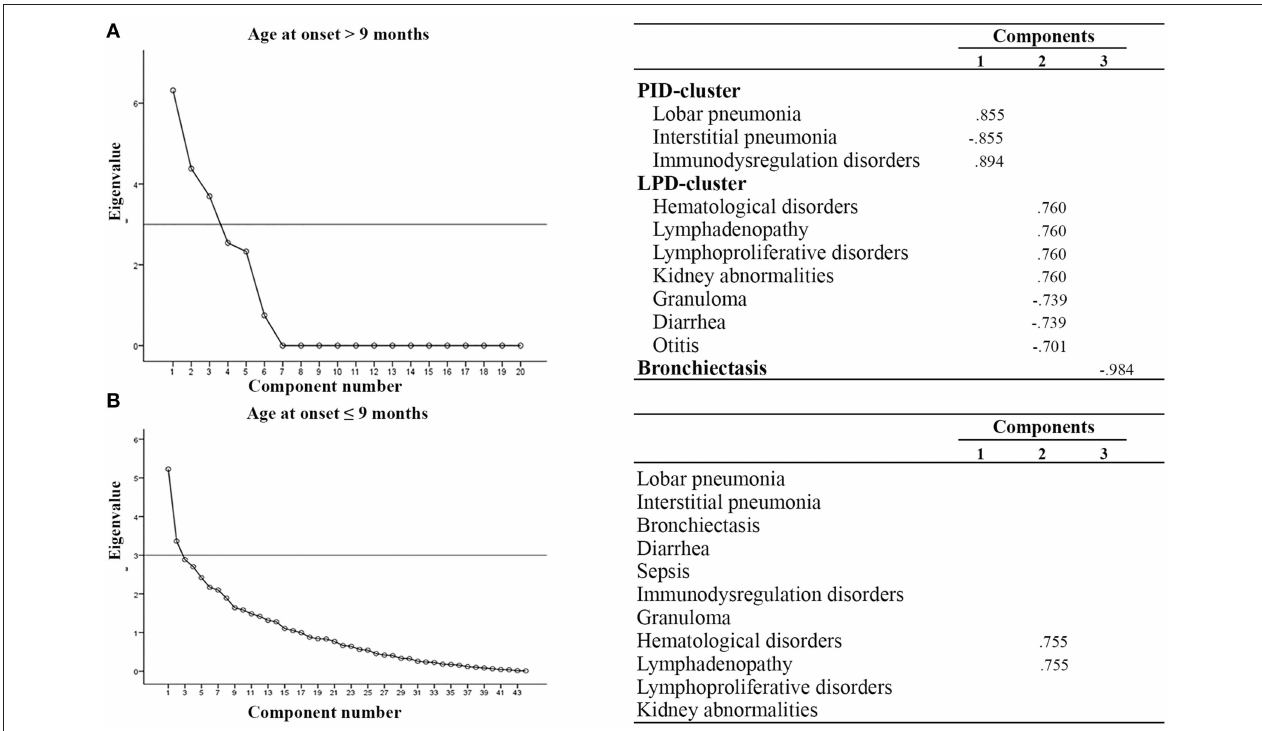
FIGURE 2 | Multivariate analysis in SCID patients according to age at onset. (A) AO > 9 mo, (B) AO ≤ 9 mo. All components with eigenvalues under 3 were dropped. Factor loadings in the analysis are illustrated in the right part of the panel. Clusters of variables positively correlated are indicated. LPD-cluster, lymphoproliferative disorder-cluster; IDP-cluster, Immuno-dysregulation and pulmonary